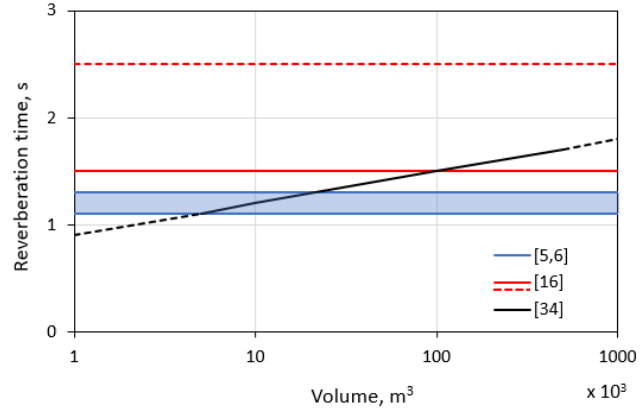
Figure 10. Recommended reverberation time in accordance with [5,6,16,34].